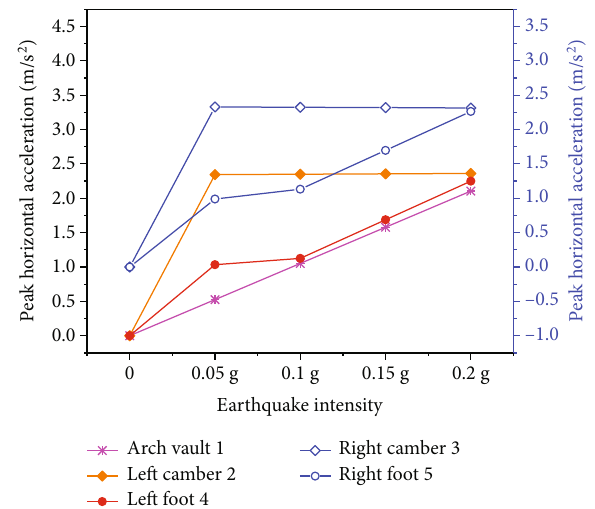
Figure 10: Peak horizontal acceleration of key points under four seismic